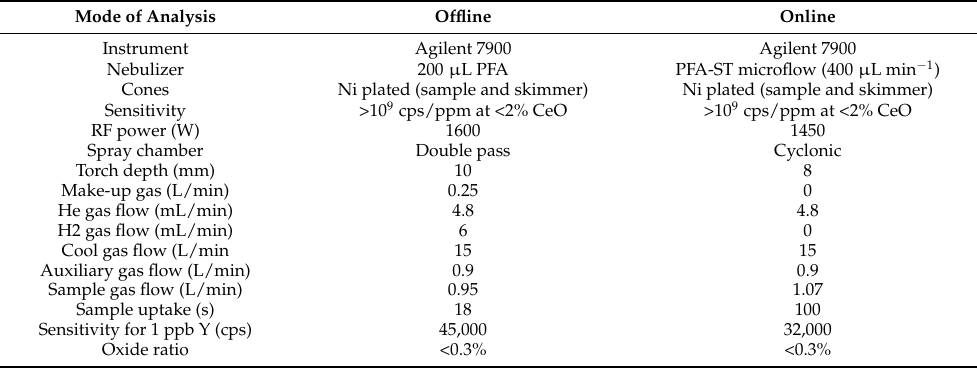
Table 2. ICP-MS operating